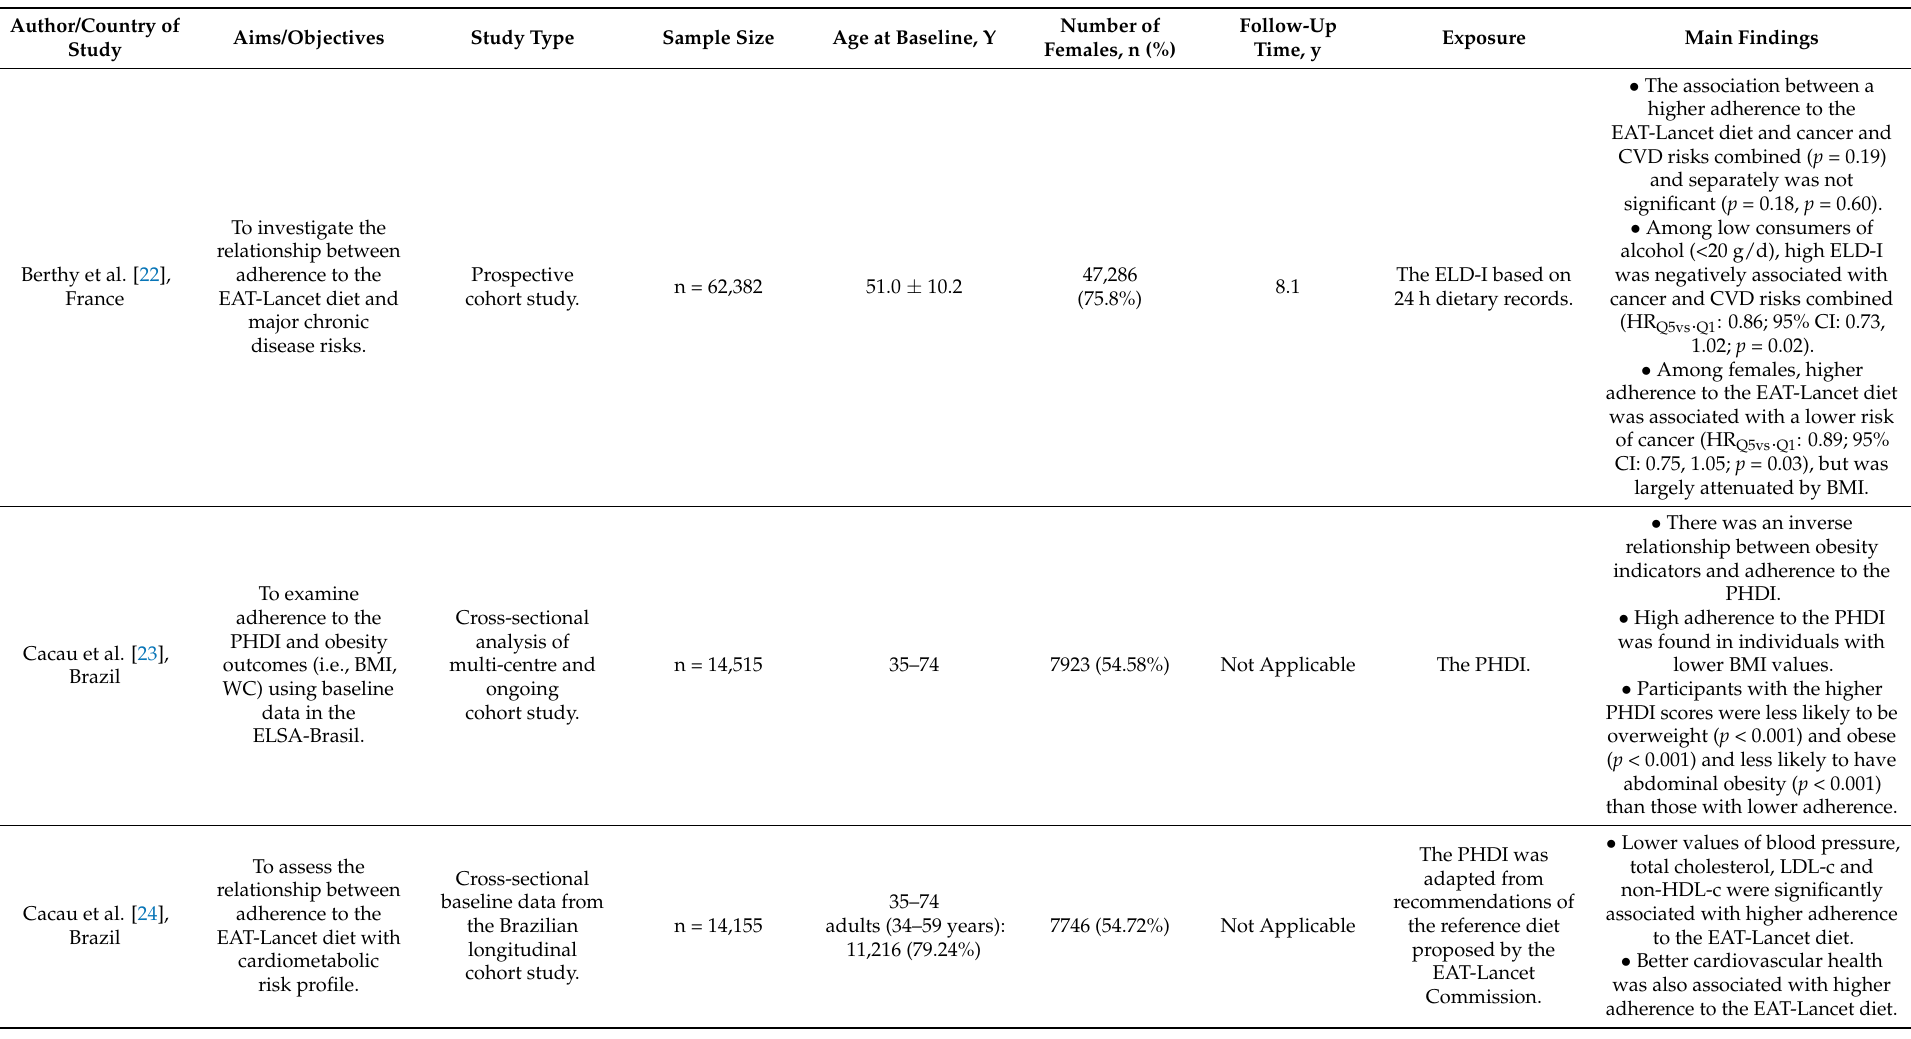
Table 2. The description and characteristics of the included